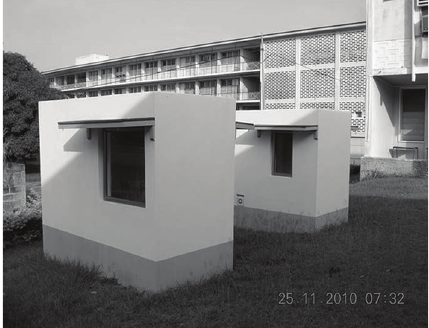
Figure 4: Test cells with